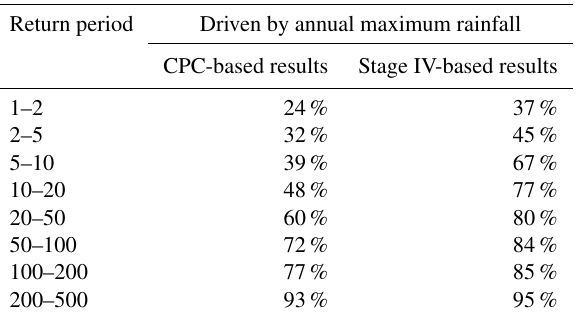
Table 3. Percentages of simulated annual maximum daily flows driven by 96h rainfall annual